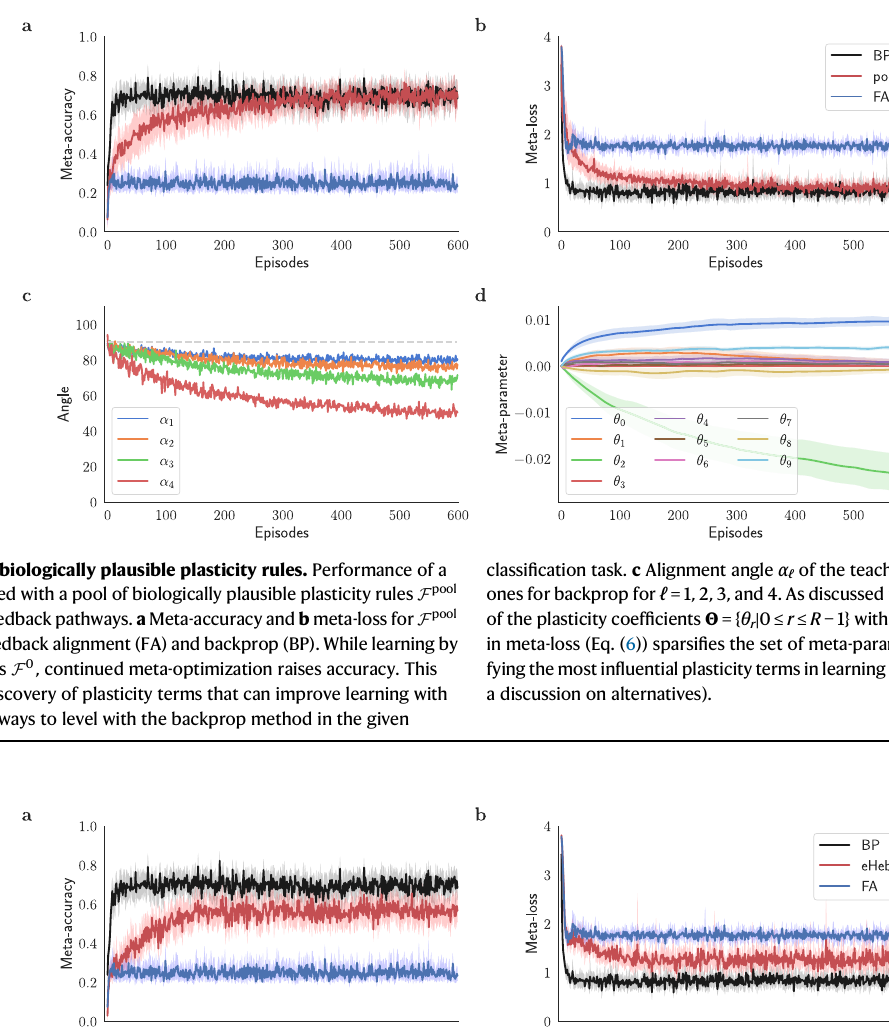
Fig. 5 | F eHebb improves learning through fi xed feedback pathways. Meta- training an image classi fi er network with F eHebb plasticity rule (eHebb; Eq. (8)) on 5-way classi fi cation tasks sampled from EMNIST dataset 49 . a Meta-accuracy and b meta-loss plots for F eHebb compared to F 0 via feedback alignment (FA) and backprop (BP), c alignment angles α ℓ for modulating signals across the network